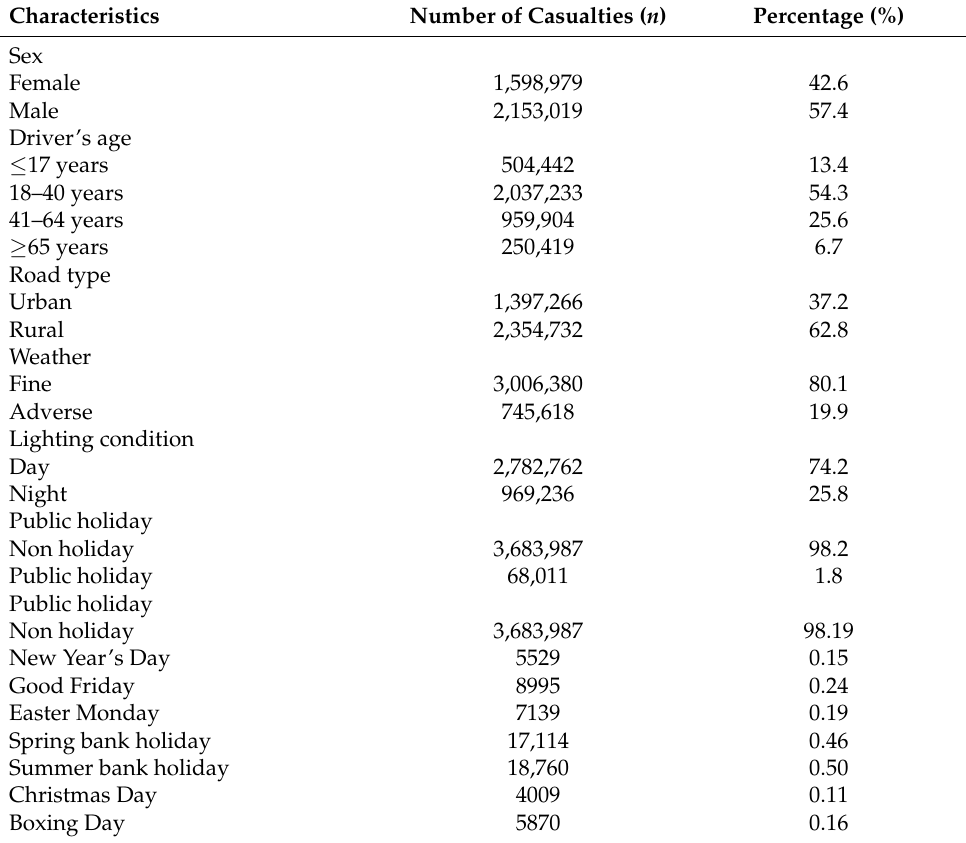
Table 1. Characteristics of casualties from 1990–2017 (Data based on UK STATS19 1990–2017) [24].